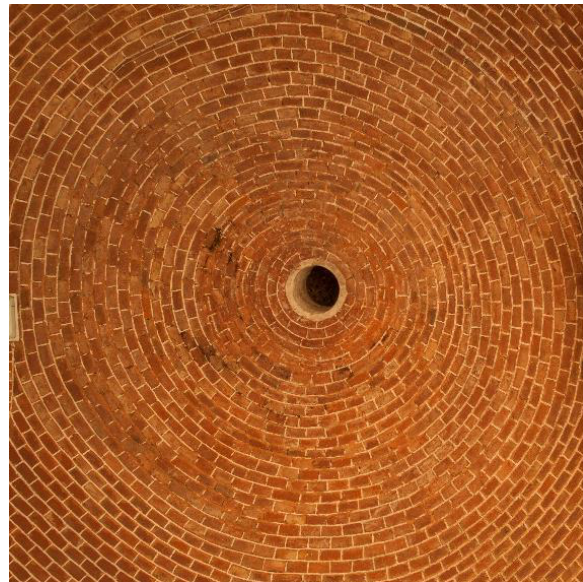
Figure 2. The masonry texture of the sail vaults.